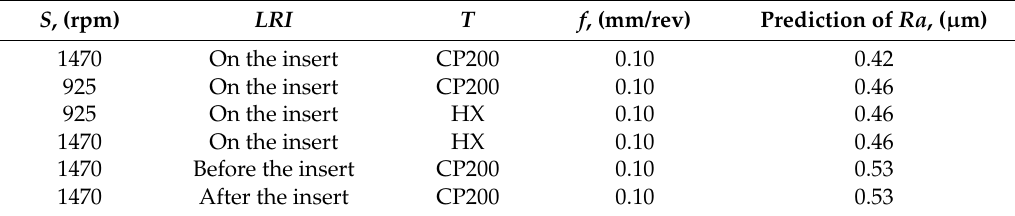
Table 9. Ranking of the combinations of the cutting